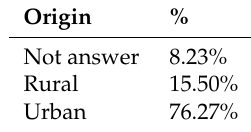
Table 2. Distribution by